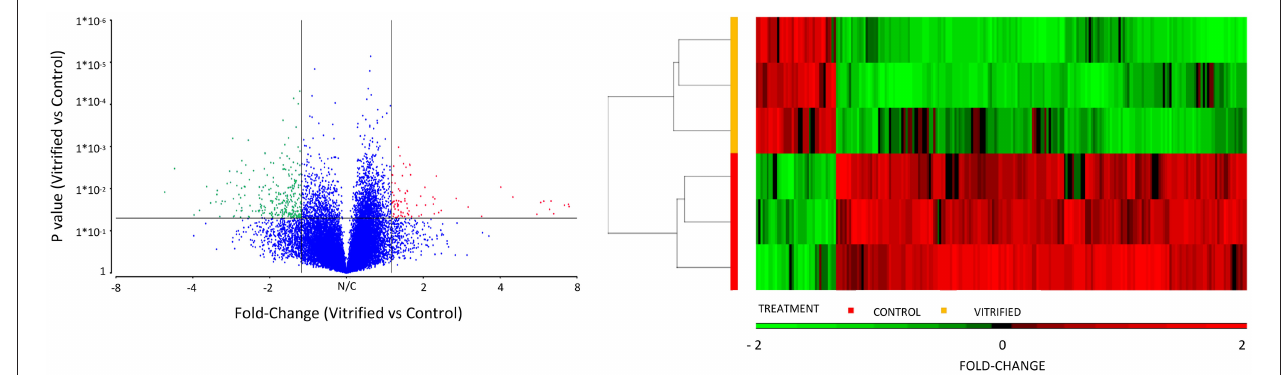
FIGURE 2 | Volcano diagram of differential gene expression of vitrified morulae compared to control morulae. Differentially expressed genes (DEGs) were considered at a fold change cut-off value of 1.5 and a P value of 0.05. Red and green dots represent up- and downregulated DEGS, respectively. Unsupervised hierarchical clustering of genes that are significantly different in the analysis of gene expression patters of vitrified morulae compared with control morulae. The color scale under the heatmap represents the level of expression.